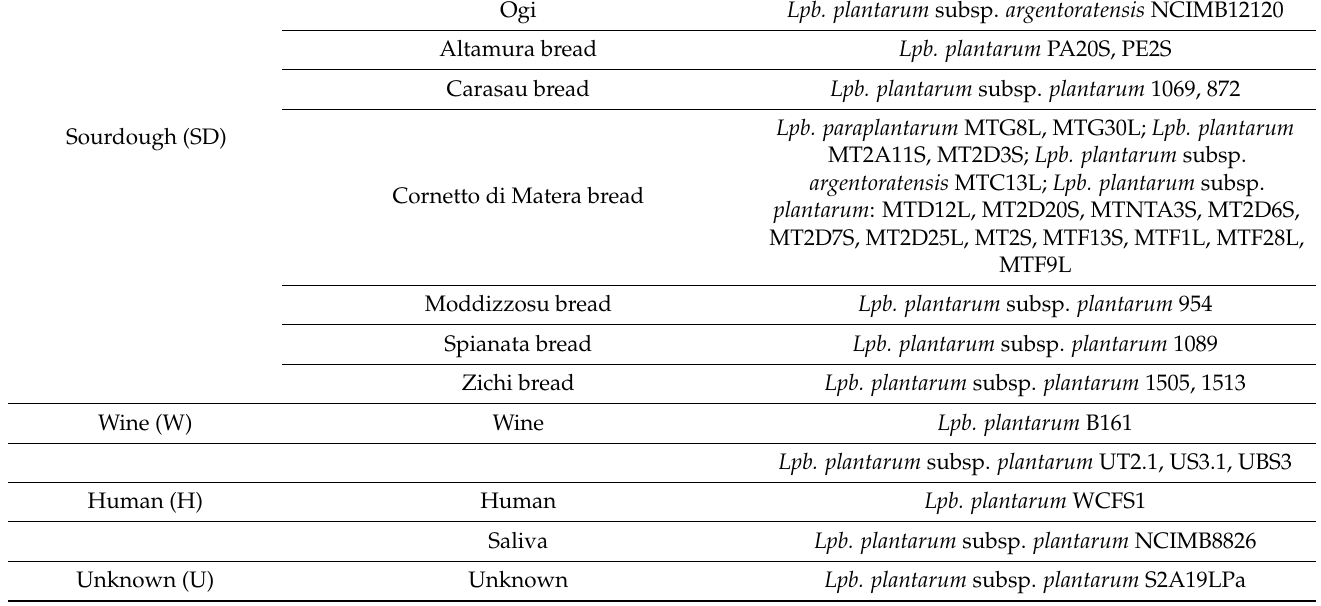
Treated table olives ( Cerignola cv.) Natural table olives ( Cerignola cv.) Brine from treated table olives ( Cerignola cv.) Brine from natural table olives ( Cerignola cv.) Table olives ( Nocellara del Belice